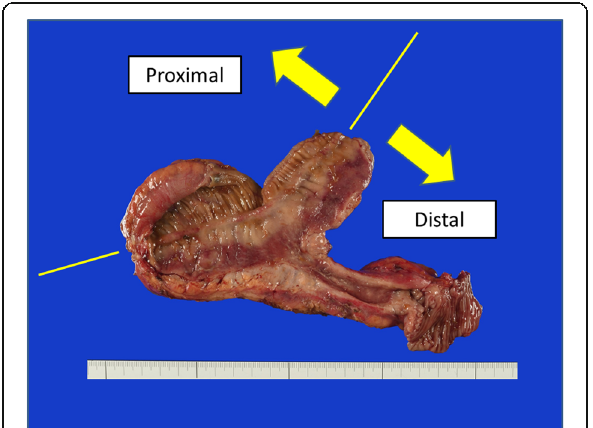
Fig. 4 Macroscopic findings of the resected specimen. The line indicates the original anastomotic site of the closed ileostomy. The intestinal wall was thickened and the Kerckring folds were absent distal to the anastomosis site. Ischemic change was not observed at the distal margin of the resected specimen